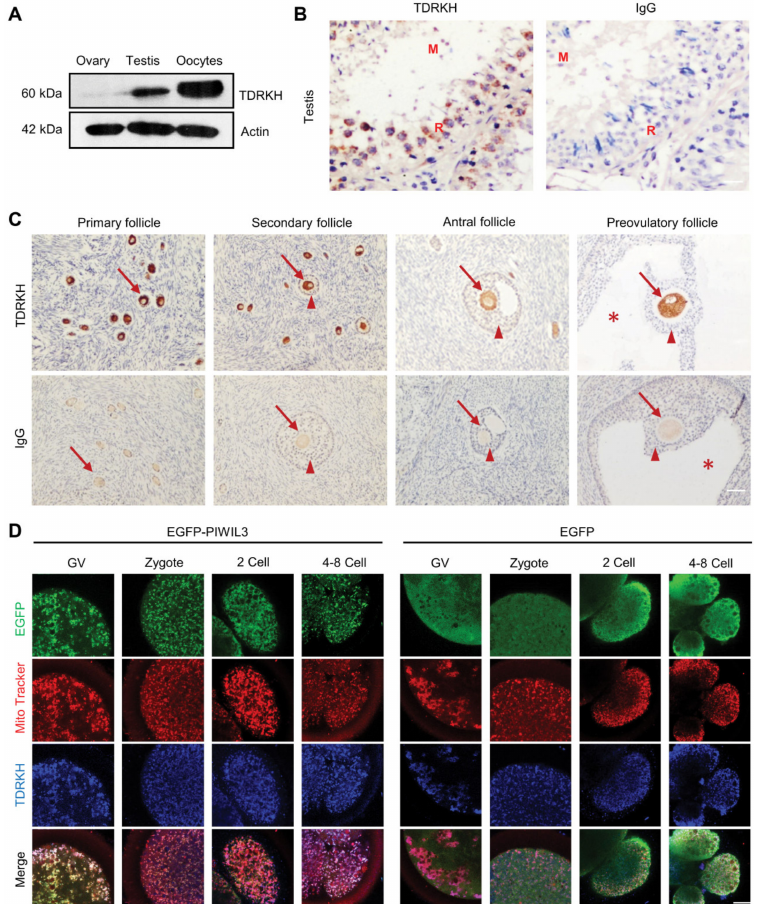
Figure 2. PIWIL3 colocalizes with Tudor and KH domain-containing protein (TDRKH) on mitochondria. ( A ) Western blot detection of TDRKH in bovine ovary, testis, as well as oocytes from antral follicles. ( B ) Immunostaining of TDRKH (brown staining) in para ffi n sections of bovine testis. Blue: hematoxylin counterstaining. R: round spermatid. M: mature sperm. Scale bar, 100 µ m. ( C ) Immunostaining of TDRKH (brown staining) in para ffi n sections of bovine ovaries in di ff erent follicular stages. Blue: hematoxylin counterstaining. Arrows indicate oocytes. Triangles indicate cumulus cells. Asterisks indicate antrum. Scale bar, 100 µ m. ( D ) Fluorescent detection of EGFP-PIWIL3 (green), EGFP (green), MitoTracker (mitochondria, red), and TDRKH (blue) in microinjected oocytes and early stage embryos. Scale bar, 20 µ